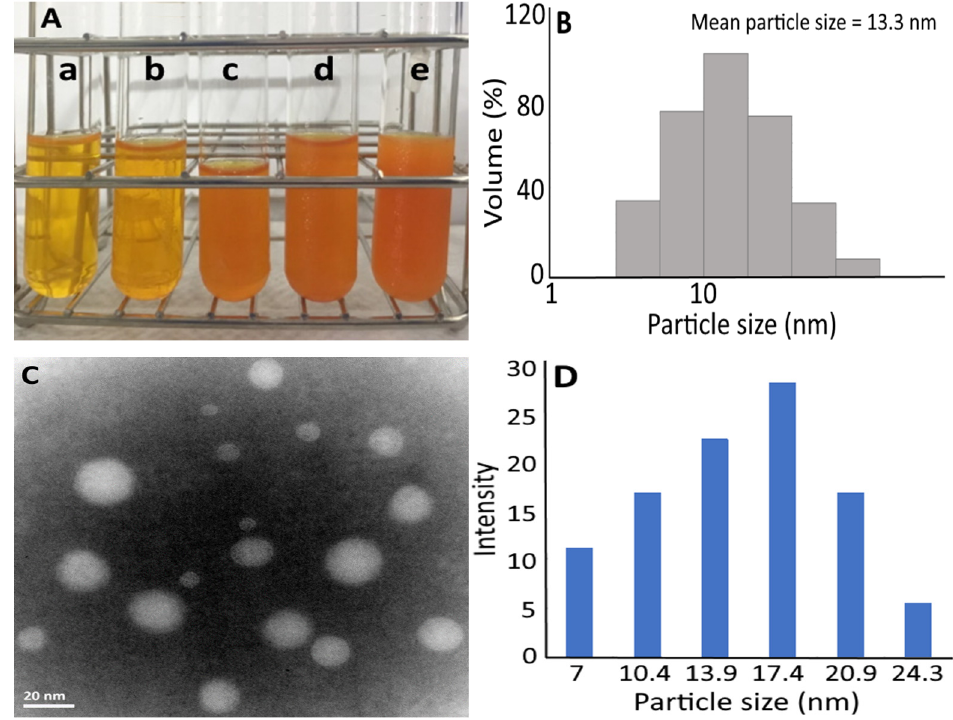
Figure 2. Appearance of carotenoid nanoemulsions prepared at different concentrations: a—1000 ppm, b—3000 ppm, c—5000 ppm, d—8000 ppm, e—10,000 ppm ( A ) along with particle size distri- bution as determined by a dynamic light scattering method ( B ) as well as their TEM image ( C ) and associated particle size distribution ( D ) from 10,000 ppm of carotenoid nanoemulsion.